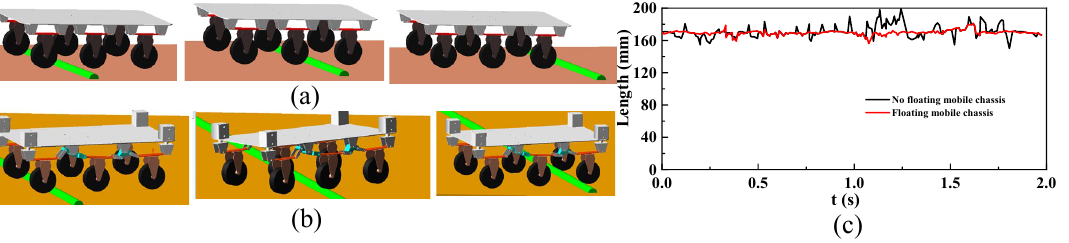
Figure 10. Motion simulation of boss crossing obstacles: ( a ) the obstacle-climbing process of no floating mobile chassis; ( b ) the obstacle climbing process of the floating mobile chassis; ( c ) simulation results–change curve of centroid height of two types of the